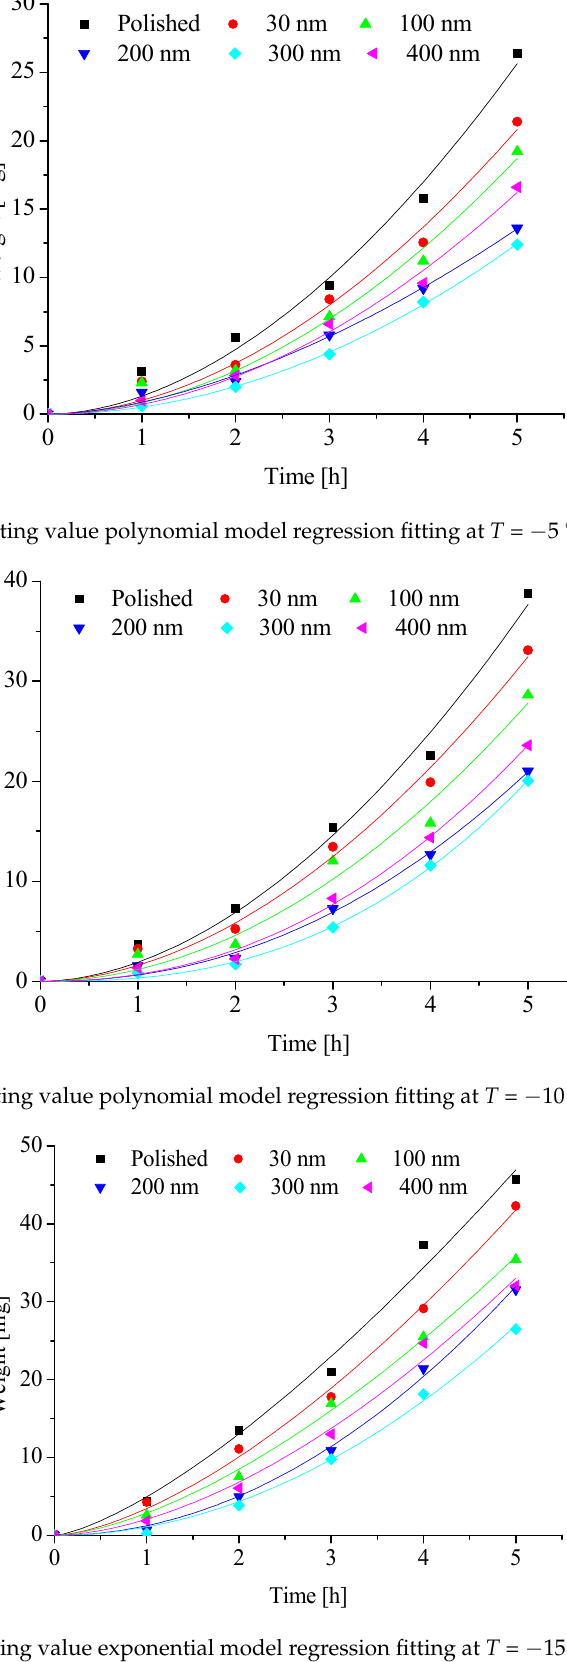
Figure 24. Testing value exponential model regression fitting at T = − 15 °C, φ = 60%.